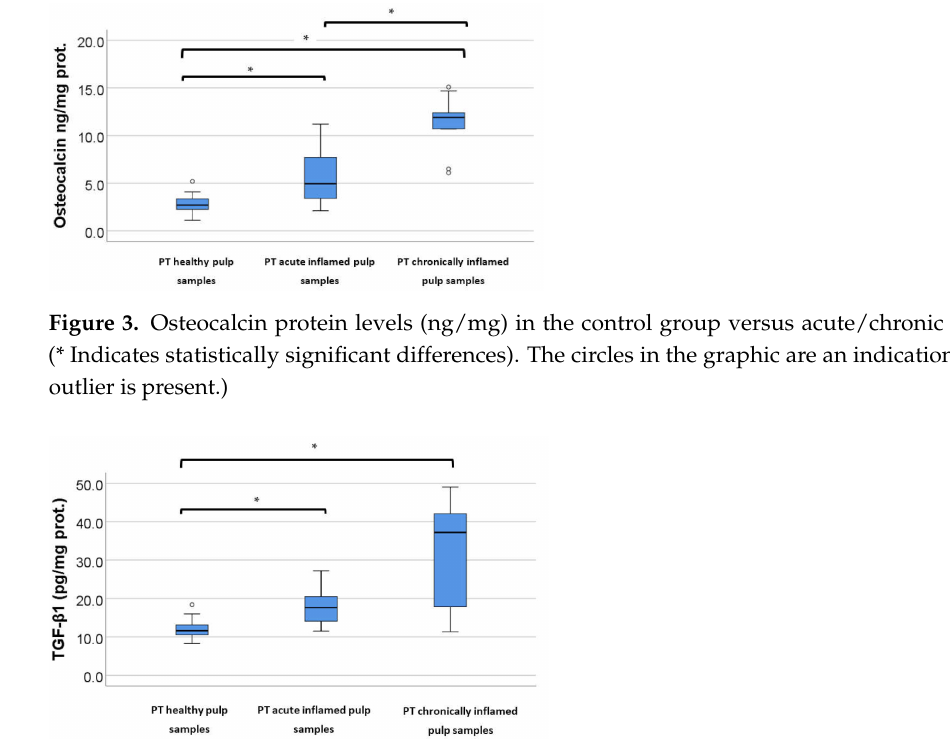
Figure 4. TGF- β 1 protein levels (ng/mg) in the control group versus acute/chronic pulpitis. (* Indicates statistically significant differences). (The circle in the graphic is an indication that an outlier is present.) Table 2. Post-hoc analysis of protein expression of biomarkers in the control and experimental groups. Comparison/Variable Healthy vs. Acute Healthy vs. Chronic Acute vs. Chronic TNF- α * <0.001 0.001 1.000 SOD-3 ** <0.001 <0.001 1.000 Osteocalcin ** 0.006 <0.001